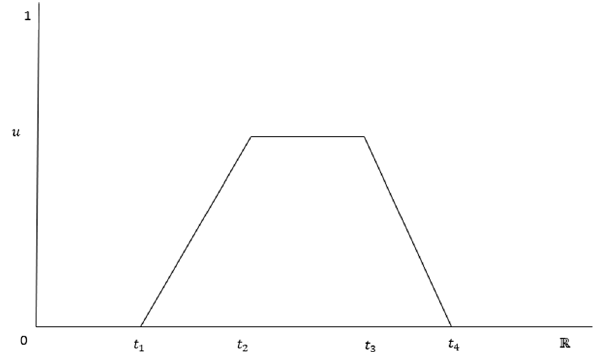
Fig. 1 Generalized trapezoidal